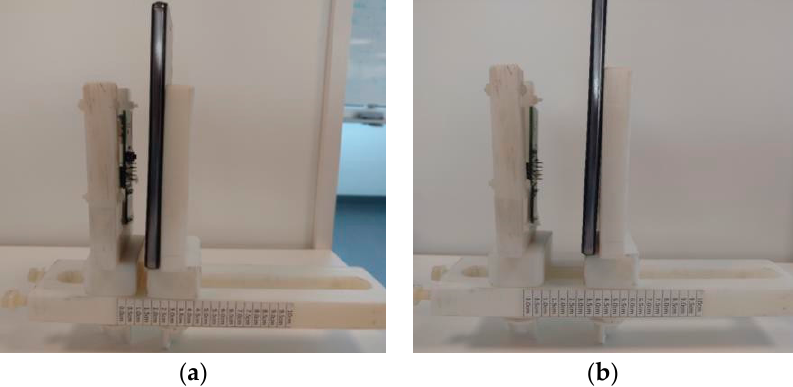
Figure 3. Setup for testing the NFC communication range with the Huawei P8 Lite: ( a ) Version 1 at the limit distance of 1 cm; ( b ) Version 2 at the limit distance of 3.0